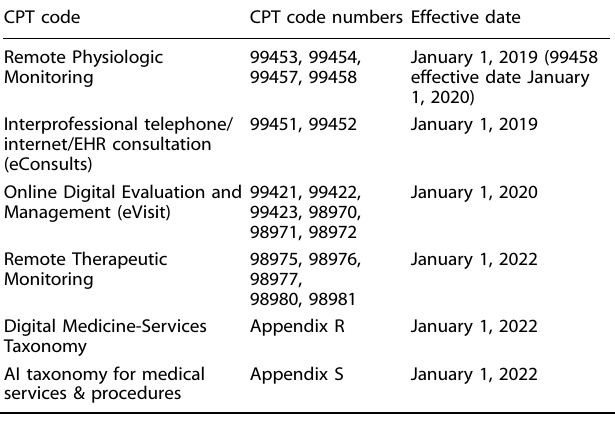
Table 1. CPT codes and appendices developed by the DMPAG.